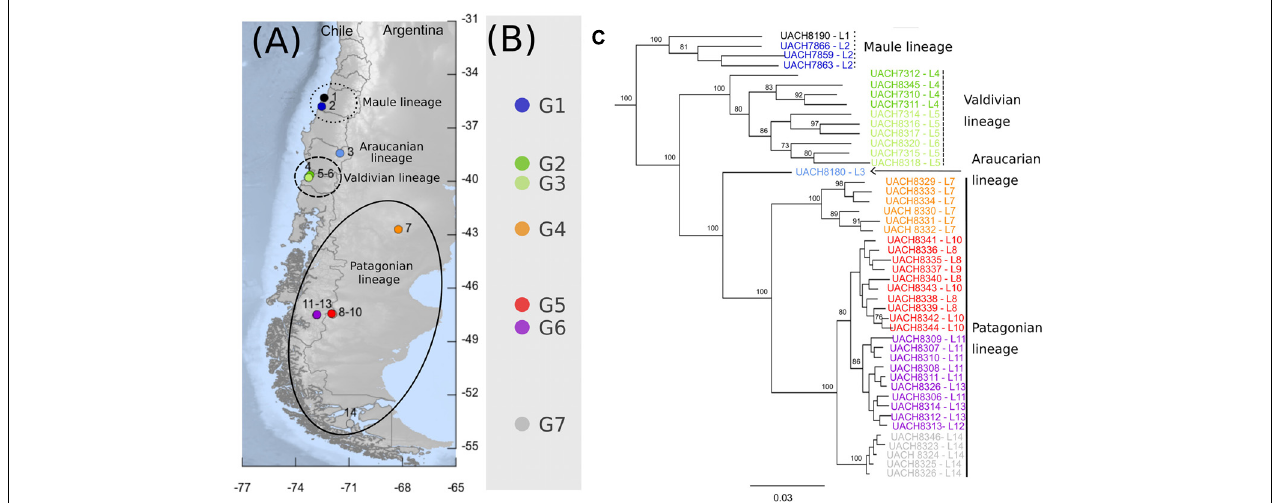
FIGURE 1 | Phylogeographic pattern of Abrothrix hirta . (A) Map of collection localities of Abrothrix hirta included in this study. Collection localities are color-coded as in Figure 3 . Circles and ellipses indicate the main lineages shown in panel (C) . (B) Groups of localities and color-coded localities within each group: G1 = 2, G2 = 4; G3 = 5-6, G4 = 7, G5 = 8-10, G6 = 11-13, G7 = 14. Localities included in each group (G1–G7). Details on each locality are provided in Table 1 . (C) Maximum likelihood tree for samples of A. hirta. Node labels correspond to Bootstrap support values. Terminals are color-coded as in panels (A) and (B) . Lineages are labeled as described in the text.